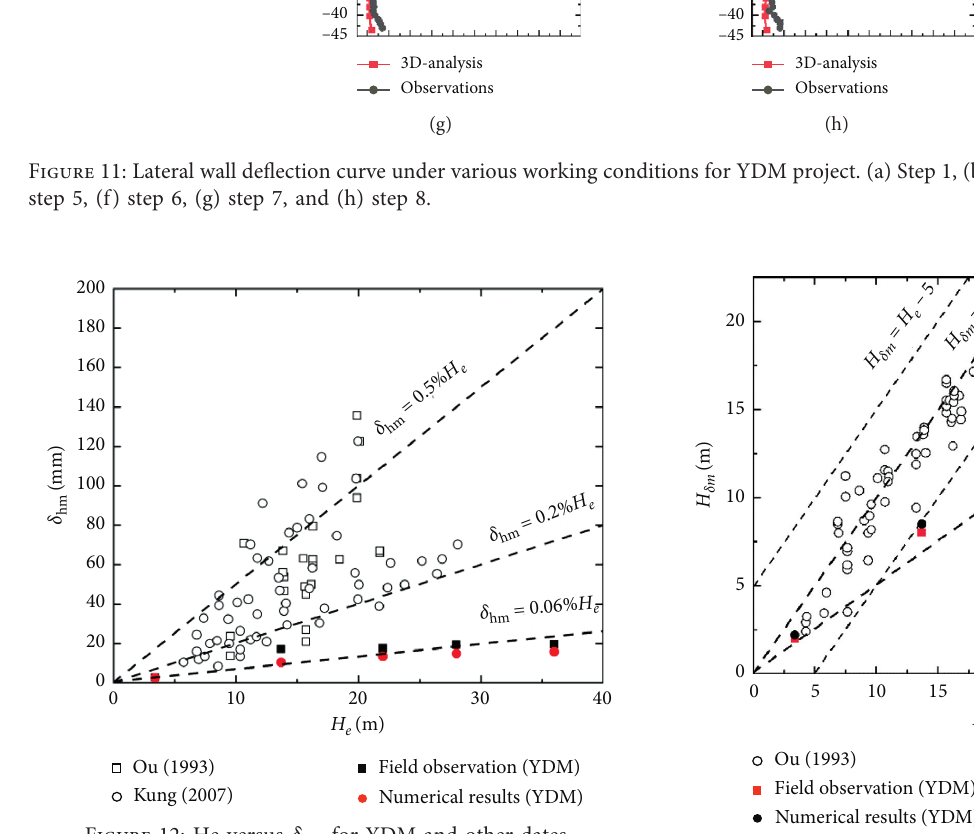
Figure 13: He versus H